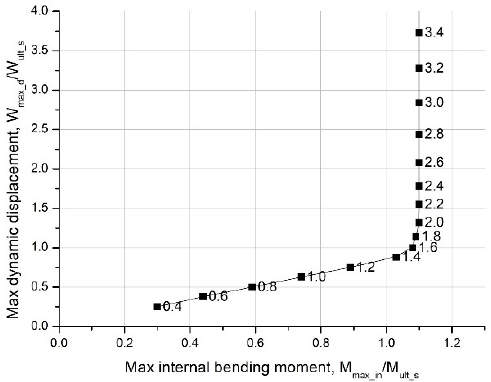
Figure 11. Internal bending moment and vertical displacement for mid-span box girder M2 at load duration time T d = 0.005 s (Data label denotes M d /M ult_s ).